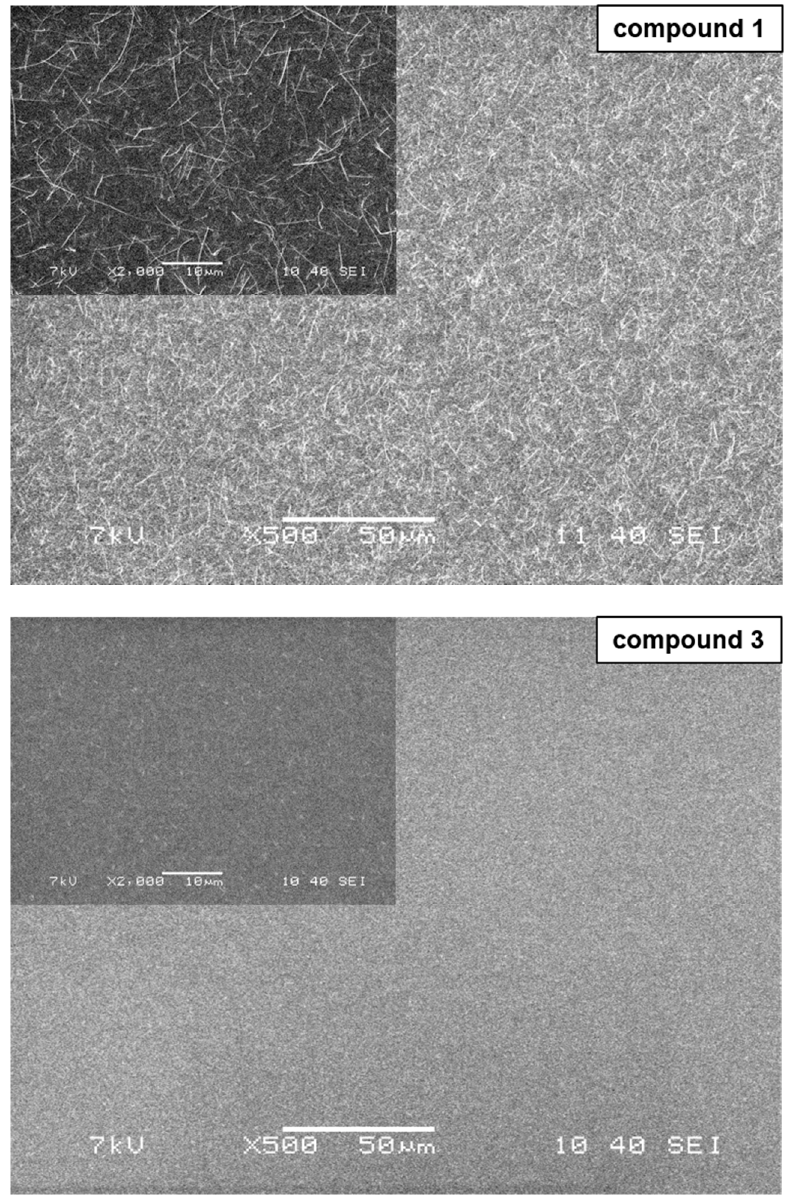
Figure 6. SEM pictures of the thin films surface of compounds 1 and 3 with a magnification of 500× and 2000×.